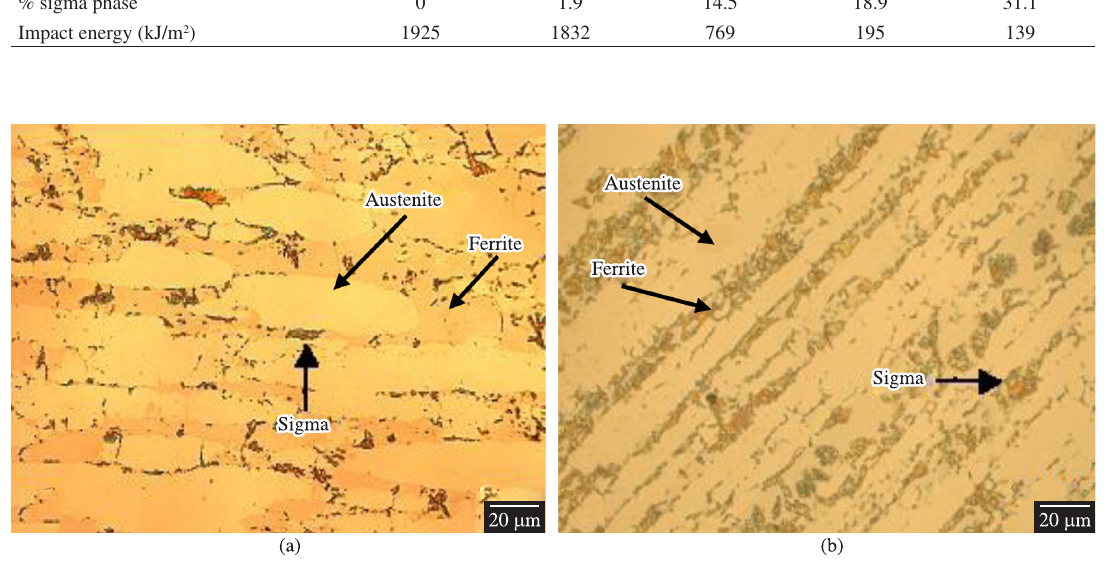
Table 2. Relationship between aging time, % sigma phase precipitated and impact energy in a 2205 stainless steel. Aging time at 850 °C (minutes)